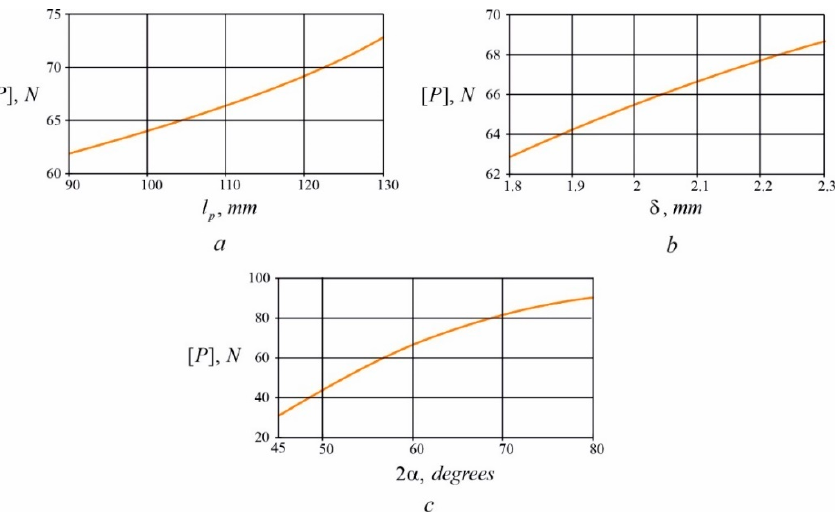
Figure 8. Dependence of the permissible value of the tightrope tightening force [ P ] on fixing plate geometrical parameters: ( a ) dependence [ P ] on the plate length l p ; ( b ) dependence [ P ] on the plate thickness δ ; ( c ) dependence [ P ] on the angular measure of the plate cross-section arc 2 α